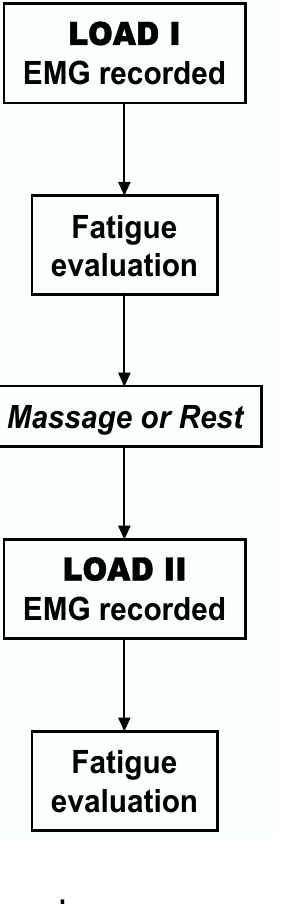
Figure 2 Experimental